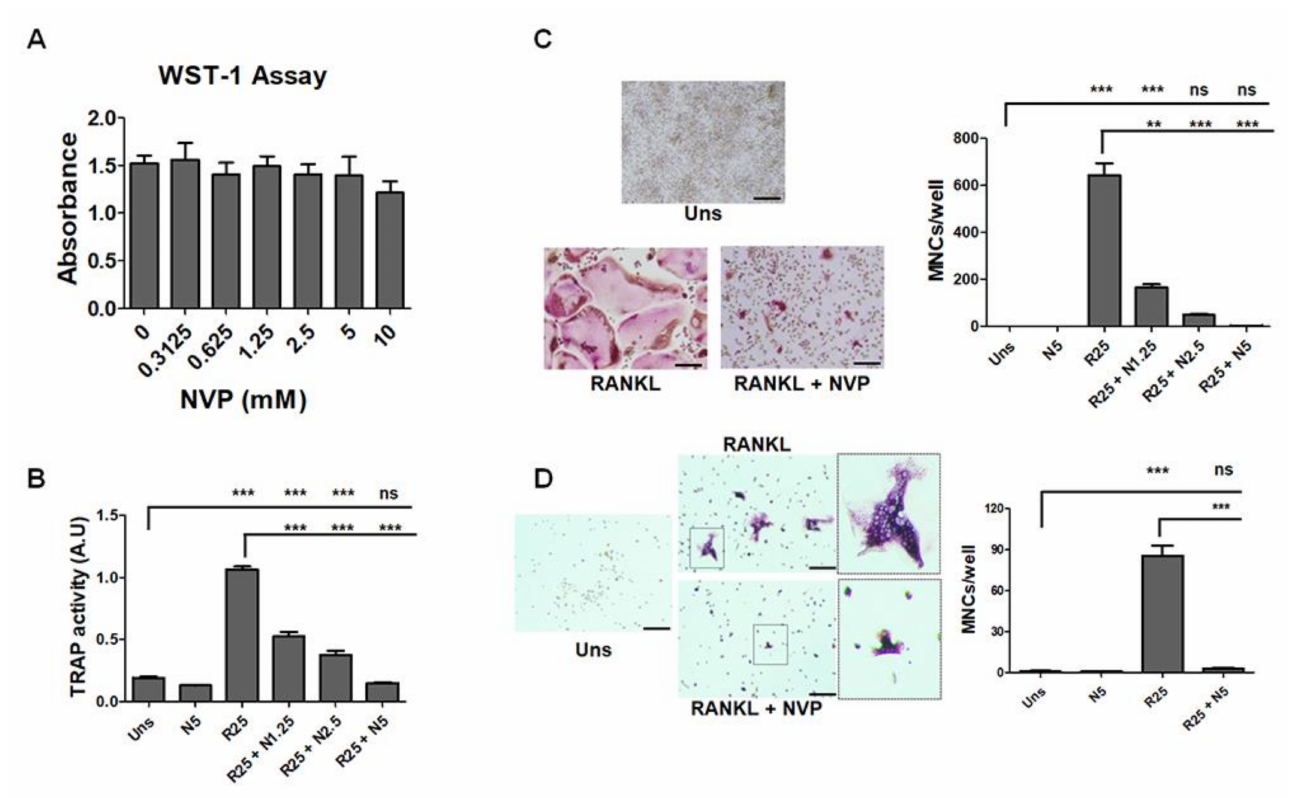
Figure 4. Effect of NVP on the viability and RANKL-induced osteoclast differentiation. ( A ) Cell viability. RAW264.7 cells were seeded on a 96-well plate, treated for 48 h as indicated in the figure. Cell viability/cytotoxicity was measured using WST-1 reagent as described in Materials and Methods. Data are expressed as mean ± S.D. ( n = 4) from a representative experiment. ( B , C ) Effects of NVP on RANKL-induced osteoclast differentiation. RAW264.7 cells were seeded in 12-well culture plates and treated with RANKL (25 ng/mL), or RANKL in the presence of an increasing concentration of NVP ranging from 1.25 to 5 mM. After 6 days, the cells were used to measure TRAP activity ( B ) or fixed and stained for TRAP to visualize TRAP-positive multinucleated cells (MNCs) ( C ) as described in Materials and Methods. ( D ) Effect of NVP on primary cells. Bone marrow-derived monocytes (BMMs) isolated from rabbit femurs were treated with RANKL (25 ng/mL) or RANKL and NVP (5 mM) in the presence of M-CSF (25 ng/mL) for 6 days. After culturing, the cells were fixed and stained for TRAP. Stained cells were photographed, and TRAP-positive MNCs containing three or more nuclei were counted as osteoclasts. Data are expressed as the mean ± S.D. ( n = 4). **: p < 0.01; ***: p < 0.001. Scale bar: 50 µ